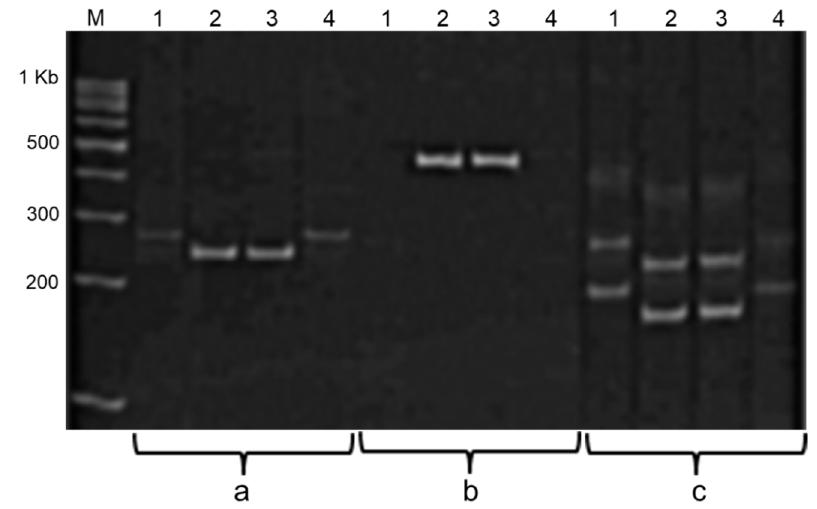
Figure 2. Amplification products of three SSR markers linked to the soybean Ti3 gene. M, Marker 100 bp; 1 and 4, Lastochka; 2, Hilario; and 3, Ascasubi. The individual marker used is indicated at the bottom as follows: ( a ) Satt228 ; ( b ) Ti/ti -gene specific marker; (c) Satt409 .